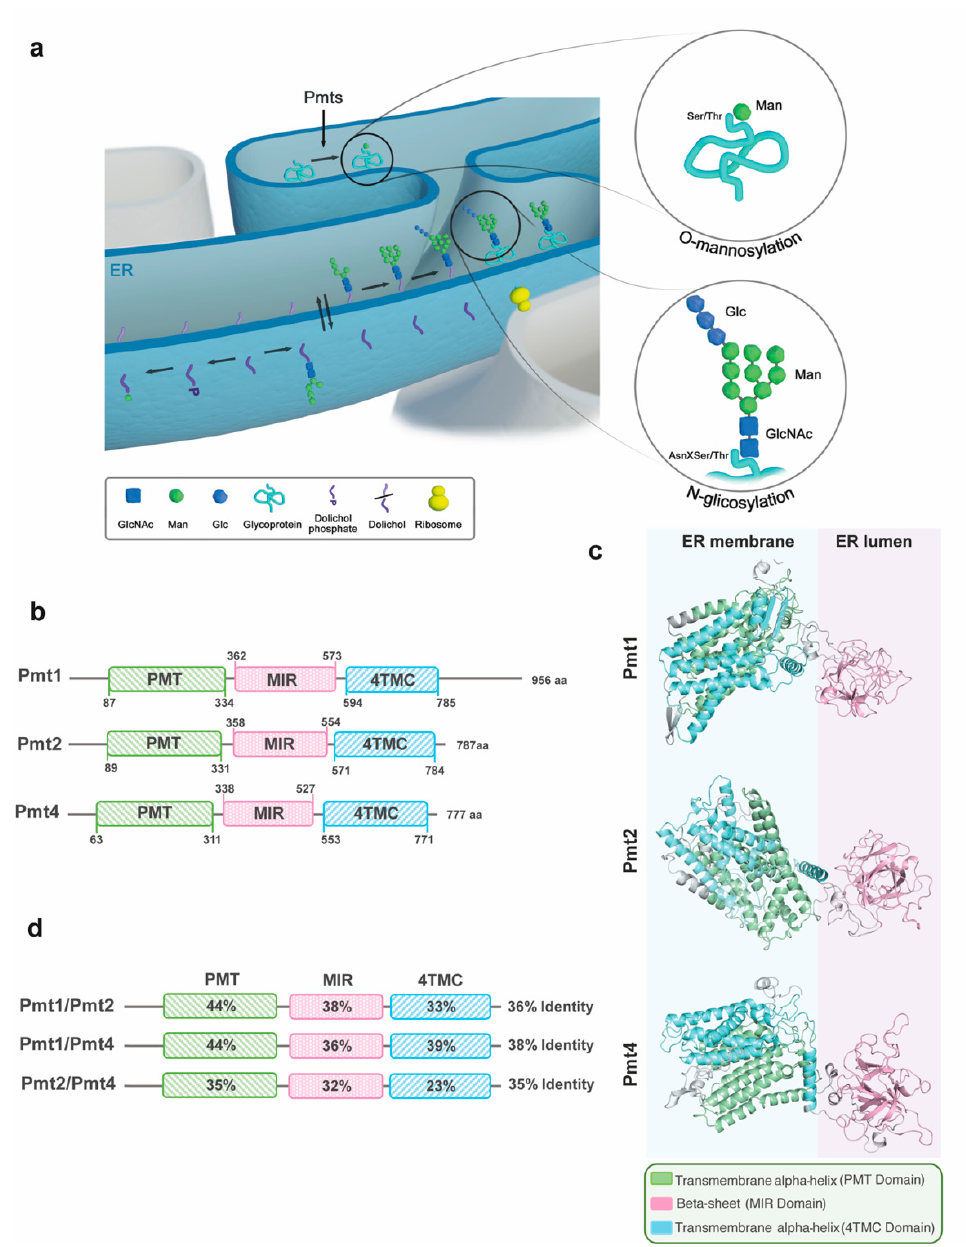
Figure 1. The Pmt protein family in the corn smut fungus Ustilago maydis . ( a ) Schematic of N-glycosylation and O-manno- sylation pathways at the endoplasmic reticulum (ER) in fungi. N-glycosylation (below); the oligosaccharide core is assem- bled on the cytoplasmatic side of the ER, then translocated into the ER where four mannose and three glucose residues are added to the structure. A circle amplifies the polysaccharide structure which is transferred to an Asn residue of the polypeptide in the sequence Asn-X-Ser/Thr. O-mannosylation (above); protein O-mannosyltransferases (Pmts) add only one mannose to the Ser/Thr residues of the target polypeptide. Nascent glycoproteins undergo a later modification at the ER and Golgi apparatus. ( b ) Schematic structure of U. maydis Pmts (UmPmts). Pmt1 (Umag_11220), Pmt2 (Umag_10749), and Pmt4 (Umag_05433) conserve the three canonical Pmt domains: PMT (green), MIR (pink), and 4TMC (blue). The do- mains were identified using the Pfam database. ( c ) Predicted topology of UmPmt family according to [42]. UmPmt pro- teins harbour seven transmembrane alpha helices in the PMT domain (green), except Pmt1 which shows six helices. The MIR harbours beta sheet structures oriented into the ER lumen. The 4TMC is composed of four transmembrane alpha helices. PDB structures were obtained using Phyre and represented using PyMol. ( d ) Similarity comparison between UmPmts. Alignments and percentages of identity were obtained using Clustal Omega.